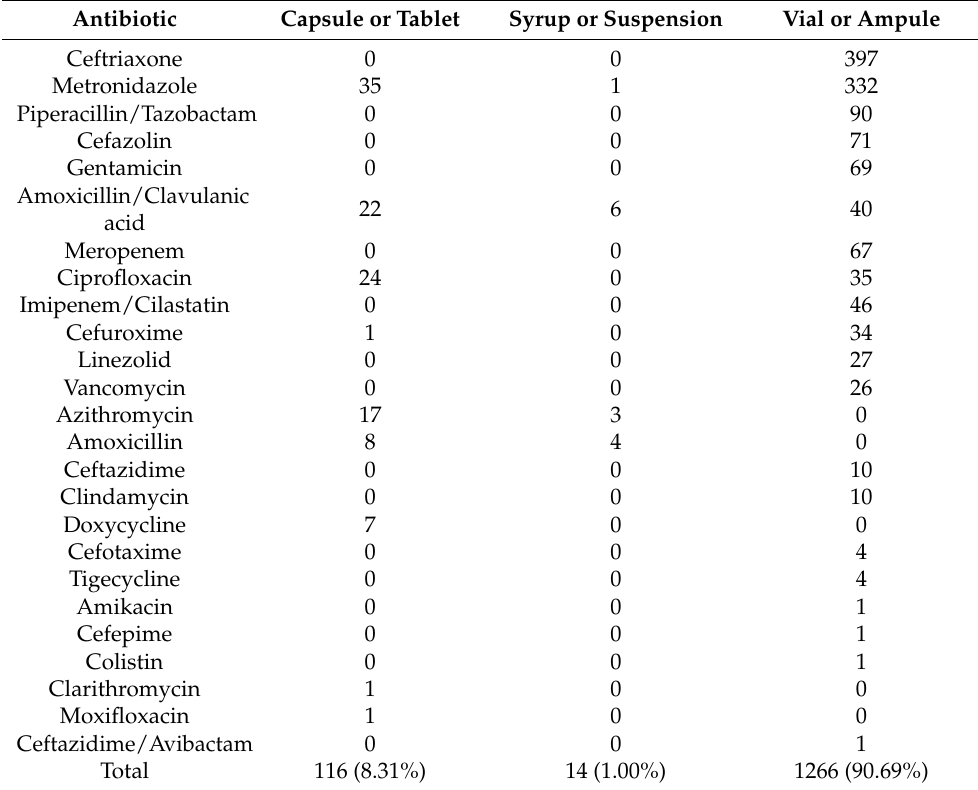
Table 3. The prescribed dosage forms of antibiotics in the surgical